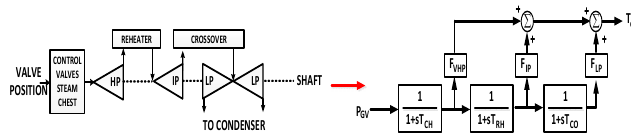
Figure A1. Configuration of the tandem compound steam turbine.